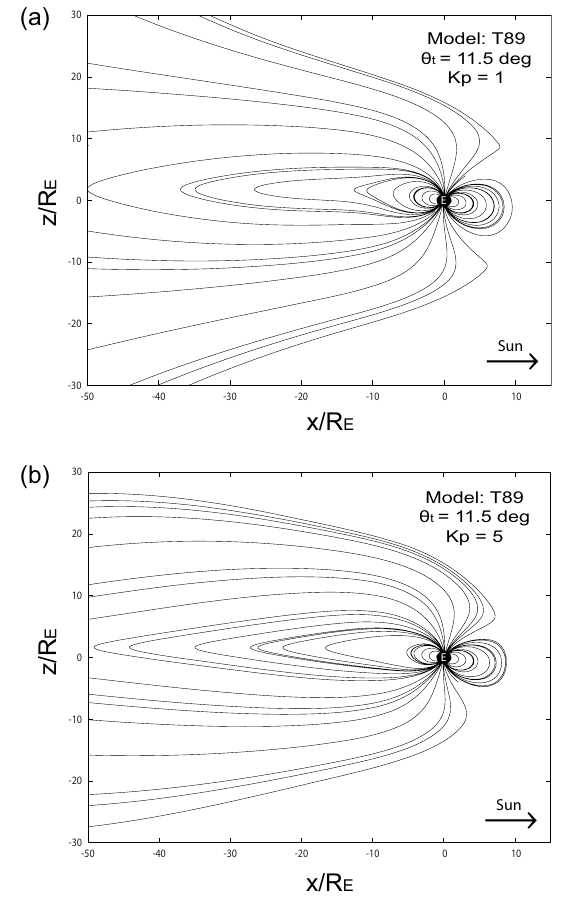
Figure 1. Geomagnetic field map on the GSM x − z plane, as calcu- lated with the T89 model, for θ t = 11 . 5 ◦ in a case where the mag- netosphere is (a) quiet (Kp = 1) and (b) disturbed (Kp =